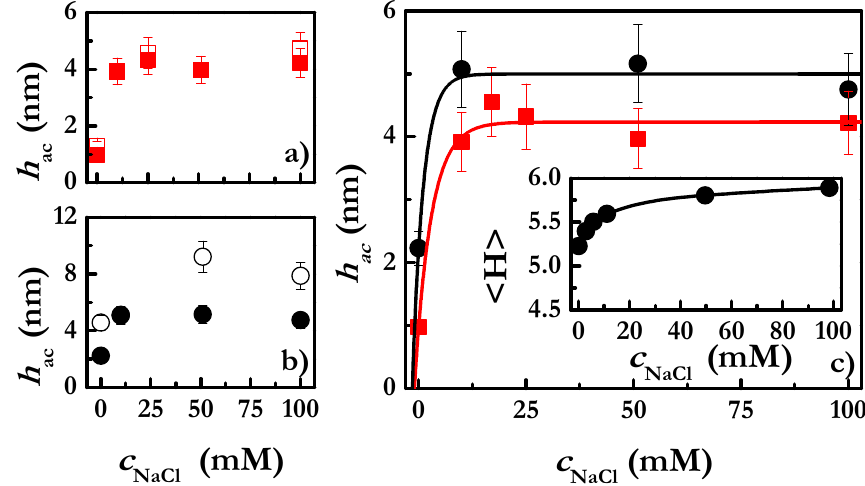
Figure 2. ( a ) Hydrodynamic thickness of polyelectrolyte layers obtained from the deposition of solutions with a polymer concentration of 2 g/L and different ionic strengths: before rinsing ( □ ) and after rinsing ( ■ ). Notice that rinsing was performed with aqueous solutions with the same NaCl concentration contained in the polymer solutions used for the deposition. ( b ) Hydrodynamic thickness of polyelectrolyte layers obtained from the deposition of solutions with a polymer concentration of 5 g/L and different ionic strengths: before rinsing ( ○ ) and after rinsing ( ● ). Notice that rinsing was performed with aqueous solutions with the same NaCl concentration contained in the polymer solutions used for the deposition. ( c ) Dependence of the hydrodynamic thickness of polyelectrolyte layers present on a negatively charged surface on the NaCl for the adsorption of CHI solutions with two different concentrations: 2 g/L ( ■ ) and 5 g/L ( ● ). The inset corresponds to the results obtained from the SCF for the NaCl concentration-dependence of the average film thickness of CHI layers deposited from solutions with a concentration of polymer equivalent to 5 g/L. The lines are guides for the eyes. Notice that the reported thicknesses correspond to those obtained after the rinsing of the adsorbed layers with aqueous solutions with the same NaCl concentration as that contained in the polymer solutions used for the deposition.